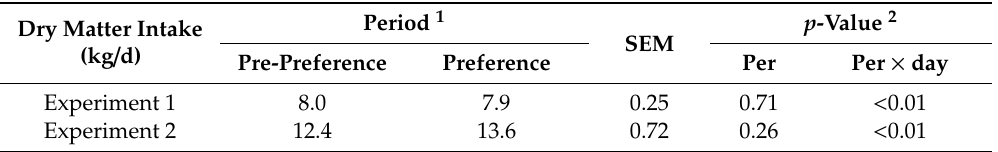
Table 2. E ff ects of a high forage (Exp. 1) or high grain diet (Exp. 2) supplemented with or without